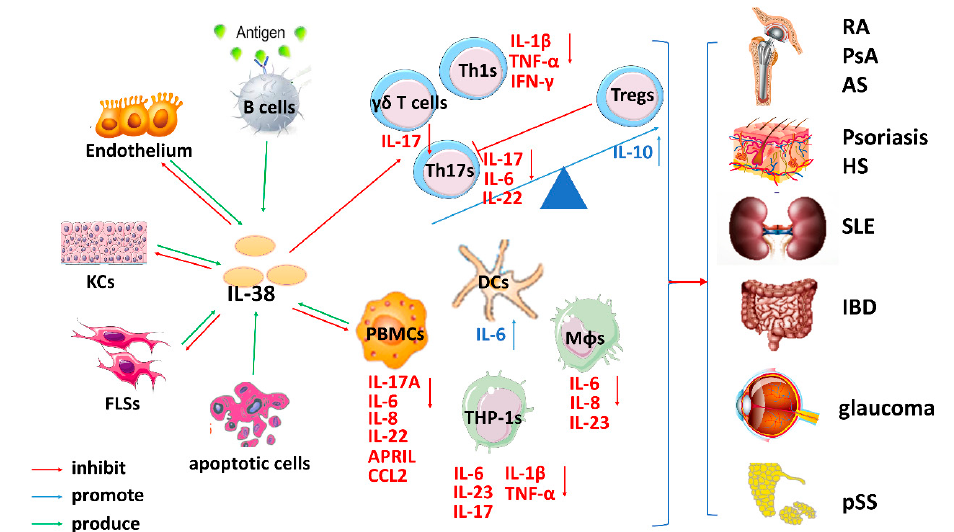
Figure 2. The complicated role of IL-38-mediated immune responses in inflammatory autoimmune diseases. After tissue damage induced by several stimuli, IL-38 is released by B cells, the endothelium, keratinocytes (KCs), fibroblast-like synoviocytes (FLSs), peripheral blood mononuclear cells (PBMCs), and various immune cells, such as dendritic cells (DCs) and macrophages (M φ s). The increased Th1/Th17/ γδ T cell numbers and decreased Treg numbers participate in the pathogenic mechanisms of many inflammatory autoimmune diseases. IL-38 inhibits Th1s, Th17s and γδ T cells activated by IL-36 or IL-1 procytokines and increases Treg numbers to decrease TNF- α , IFN- γ , IL-1 β , IL-6, IL-22, and IL-17 expression. Additionally, IL-38 exerts bioeffects on PBMCs, human leukemia monocytic cell line (THP-1s), DCs and M φ s to inhibit the cytokines IL-6, IL-8, IL-17, IL-22, and IL-23, which further suppresses the differentiation and expansion of Th17s. Consequently, IL-38 inhibits the development of several inflammatory autoimmune diseases by creating dysfunction in Th1s / Th17s / γδ T cells and promoting Treg